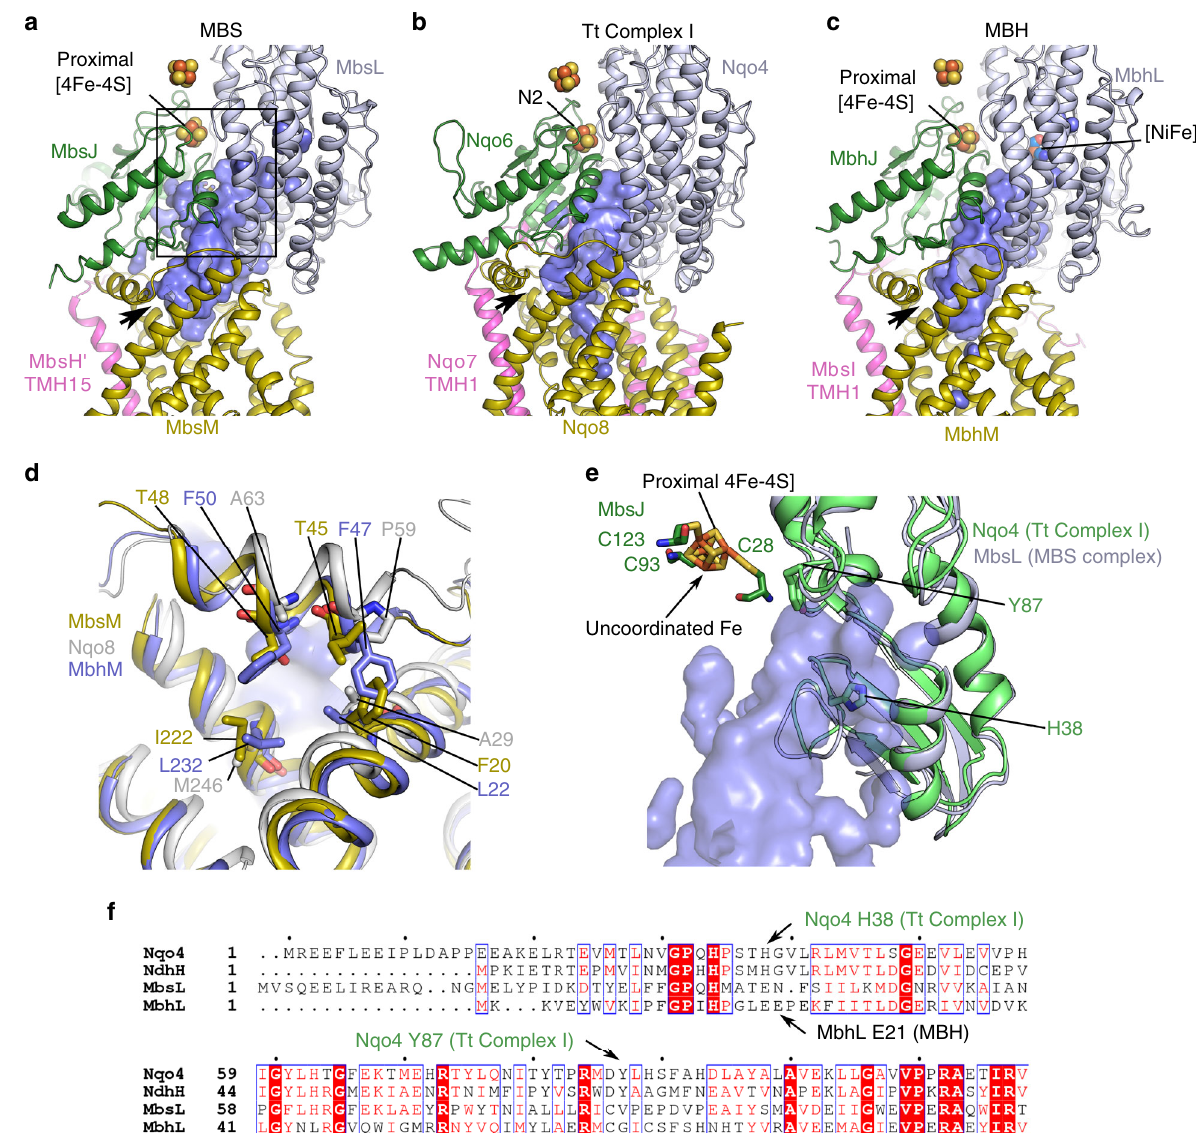
Fig. 5 A comparison of the chamber at the active sites of MBS, MBH and complex I. The structures were overlaid based on MbsM, Nqo8, and MbhM and are shown individually. The chamber is similarly formed at the interface between the peripheral arm and its membrane anchor. The black arrow indicates the opening of the chamber proposed as the entrance of quinone in complex I studies. a MBS. b Complex I (PDB ID 4HEA). c MBH (PDB ID 6CFW). d A comparison of the chamber entry between MBS, MBH, and complex I indicate a wider opening in MBS and complex I than that in MBH. e Zoomed view of the end of the active site chamber, outlined as the boxed region in ( a ). The aligned Nqo4 of Tt complex I is shown as a green cartoon where two residues (H38 and Y87) proposed for the binding of the quinone headgroup are shown as sticks. f Sequence alignment of MbsL with its counterparts in different respiratory complexes (Nqo4 of Tt complex I, NdhH of NDH complex, MbhL of MBH complex I). Residues equivalent to Nqo4 H38 and Y87, proposed for quinone headgroup binding and protonation in complex I, and MbhL E21, the key residue for proton reduction in MBH complex, are all absent in